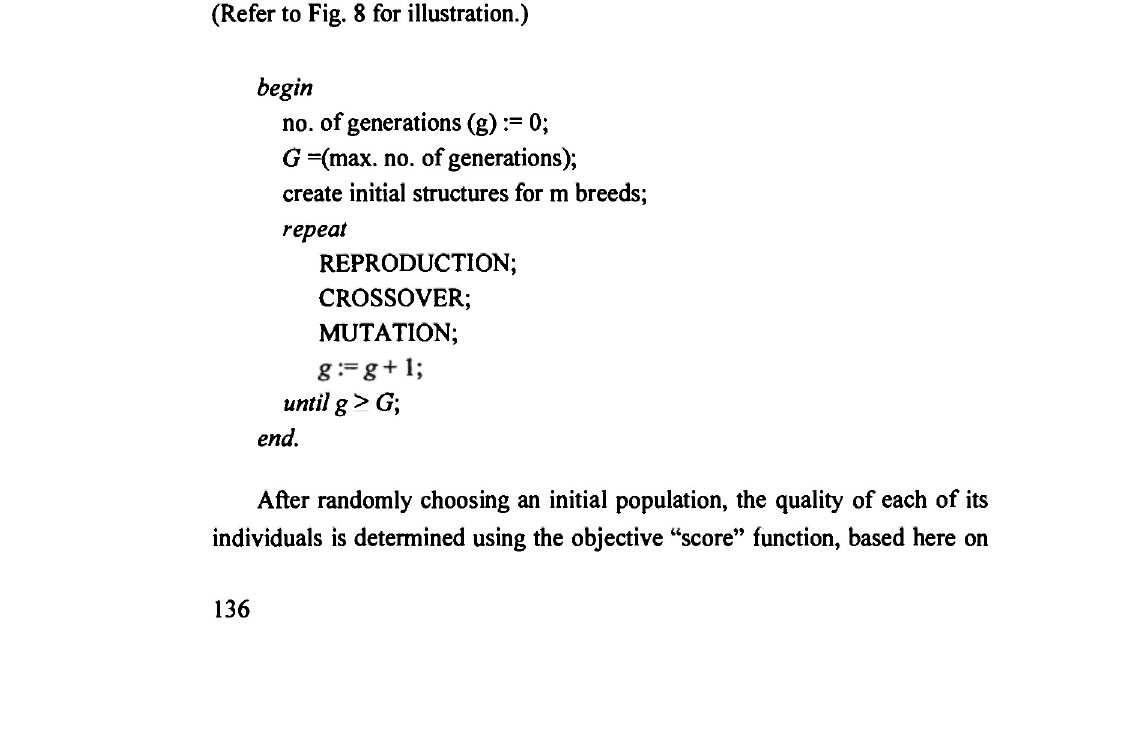
Fig. 7: A further illustration of the causal network CE\